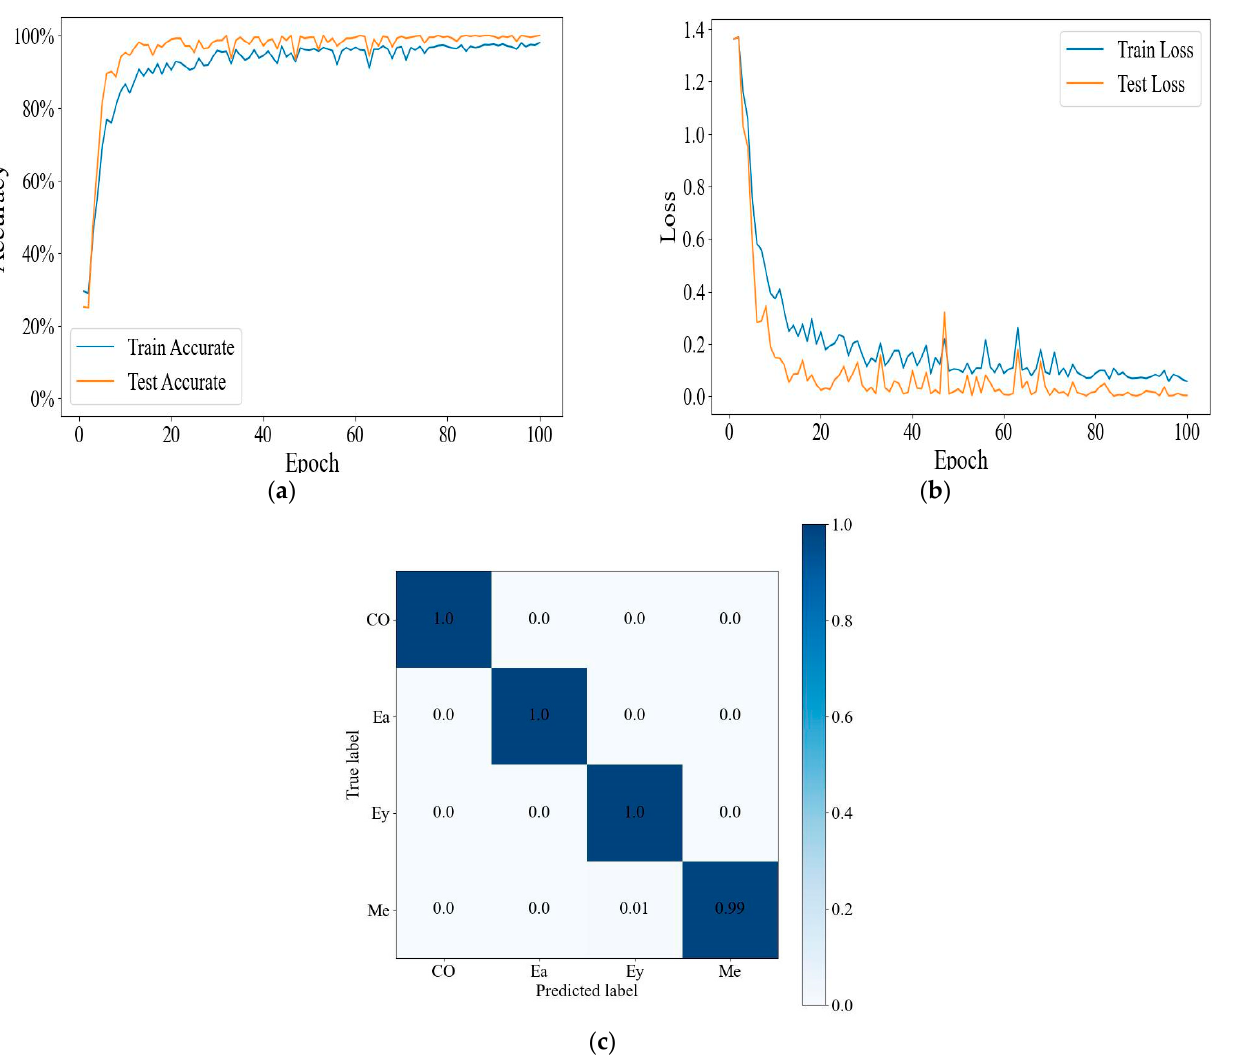
Table 5. The experimental results